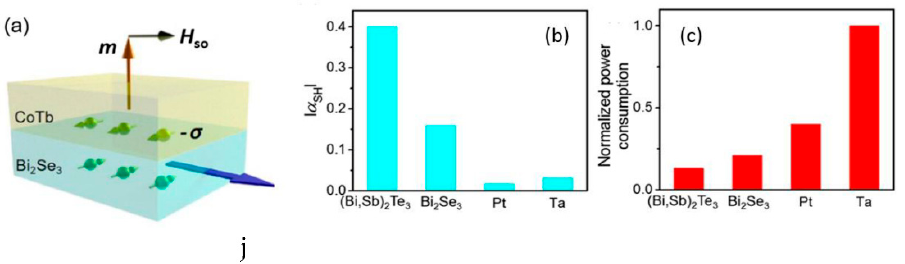
Figure 10. ( a ) Schematic heterostructure TI/RE–TM alloy. The charge current j e generates spin accumulation ( − σ ) that is perpendicular to the current direction at the interface and exerts a spin–orbit torque on the magnetic moment in the CoTb PMA alloy. ( b , c ) Absolute values of the effective spin Hall angle and power consumption of different spin–orbit materials, showing the higher efficiency of TI vs. traditional heavy metals such as Ta and Pt. Reprinted with permission from ref. [76]. 2017 APS .